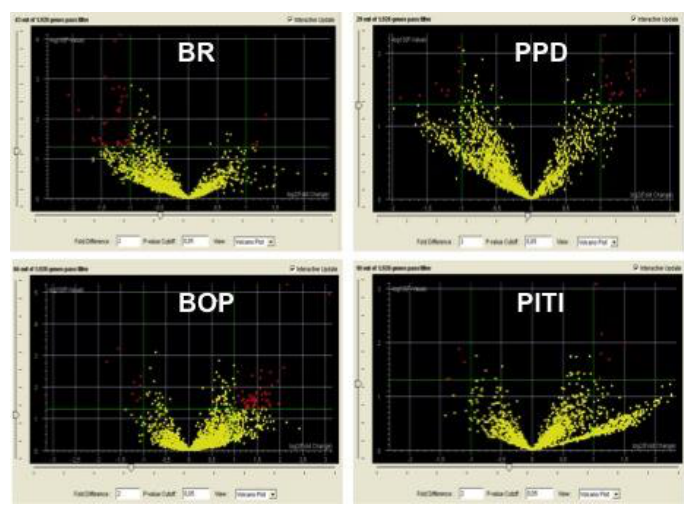
Figure 3. Volcano plot analyses reporting the number of significantly (<2-fold, p < 0.05) altered miRNAs as related to the outcome of the following clinical variables recorded at the five-year